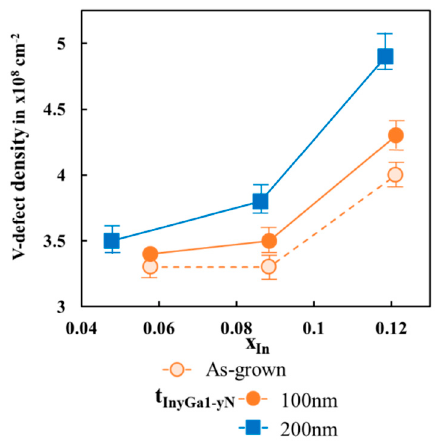
Figure 4. The average V-defect density of the sample surface vs. mole-fraction x of as-grown In x Ga 1 − x N layers, for as-grown samples (open circles), after regrowth of 100 nm In y Ga 1 − y N layers (filled circles) or 200 nm In y Ga 1 − y N layers (filled squares).